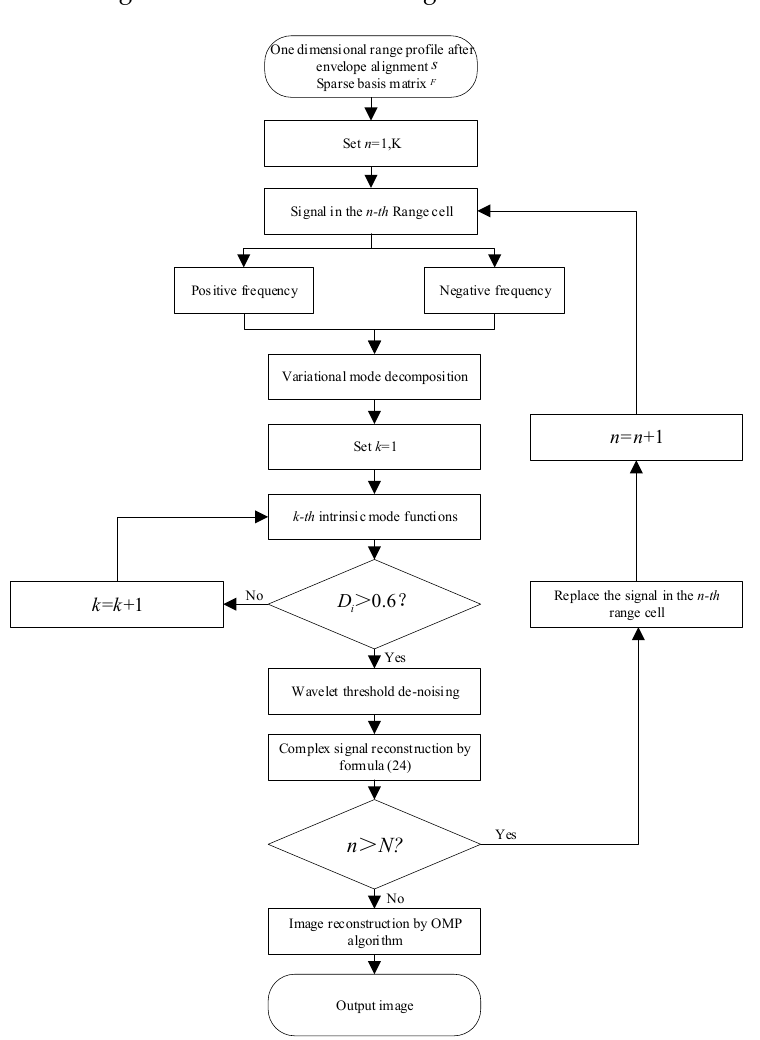
Figure 2. Bi–ISAR sparse aperture high resolution imaging algorithm flow at low Figure 2. Bi − ISAR sparse aperture high resolution imaging algorithm flow at low SNR.